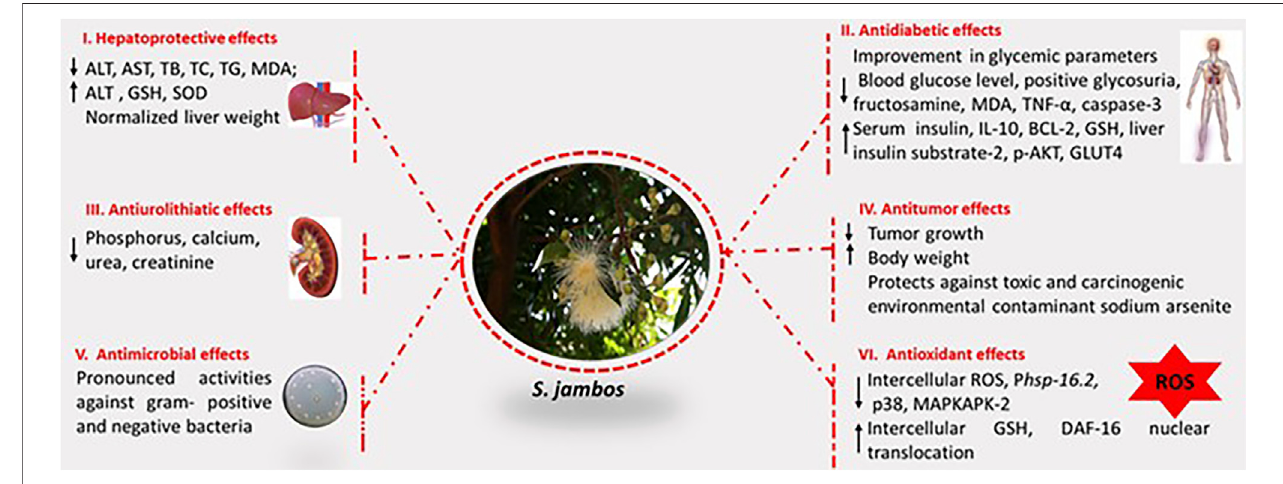
FIGURE 3 | Biological activities of S. jambos